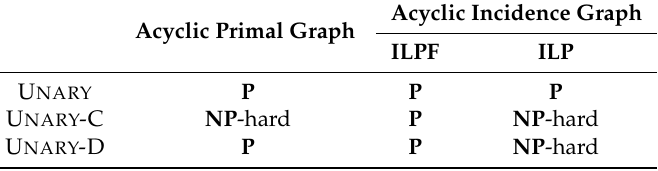
Table 1. The complexity map for ILP ≤ for unary instances (first row), instances whose coefficients are encoded in unary (second row), and instances with unary bounded domain (third row). Without these restrictions, the problem becomes intractable due to the simple acyclic structure of the classical encoding of S UBSET S UM into ILP.